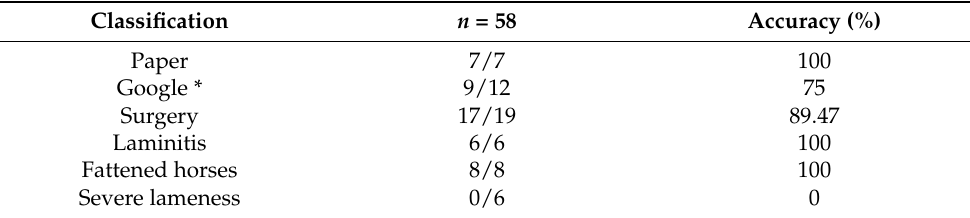
Table 4. Accuracy according to the classification of equine pain in the test.